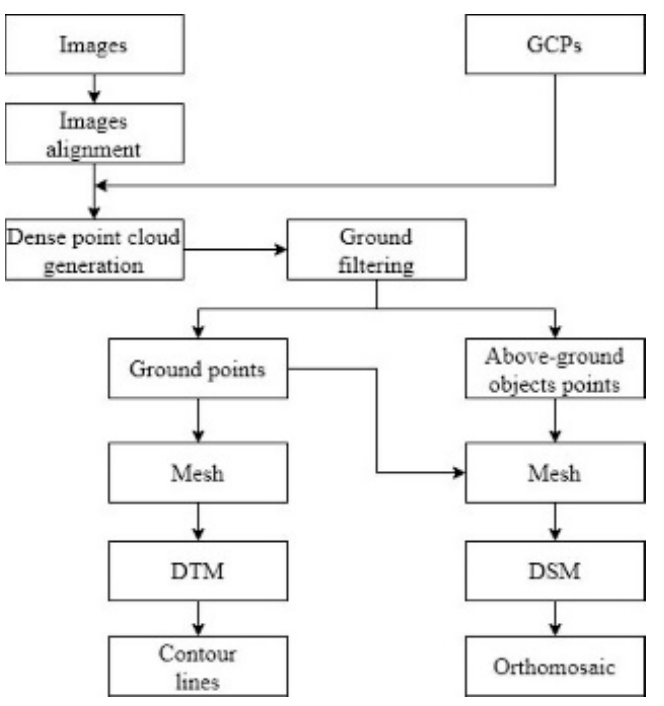
Figure 4. Workflow to generate DTMs.